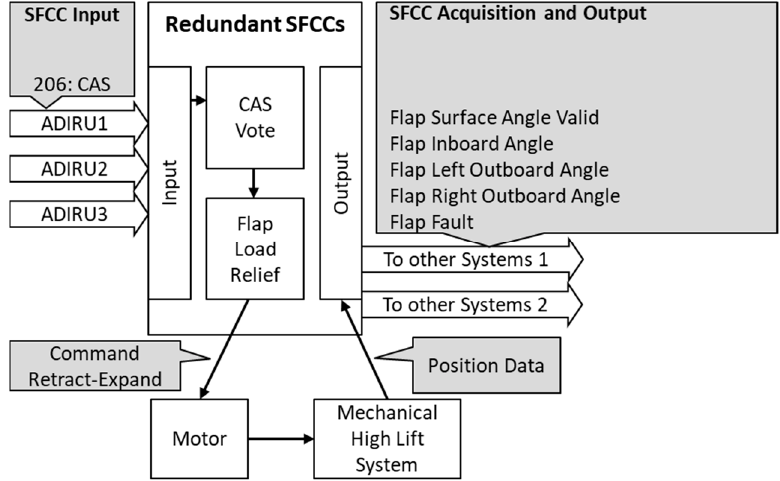
Figure 12. Architecture of the flap load relief test scenario.